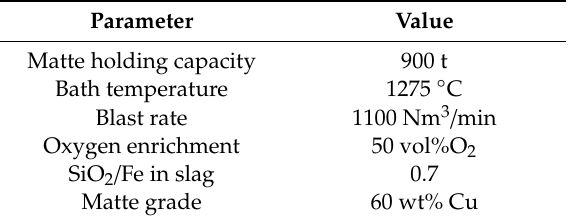
Table 2. Examples of smelting furnace operational parameters.